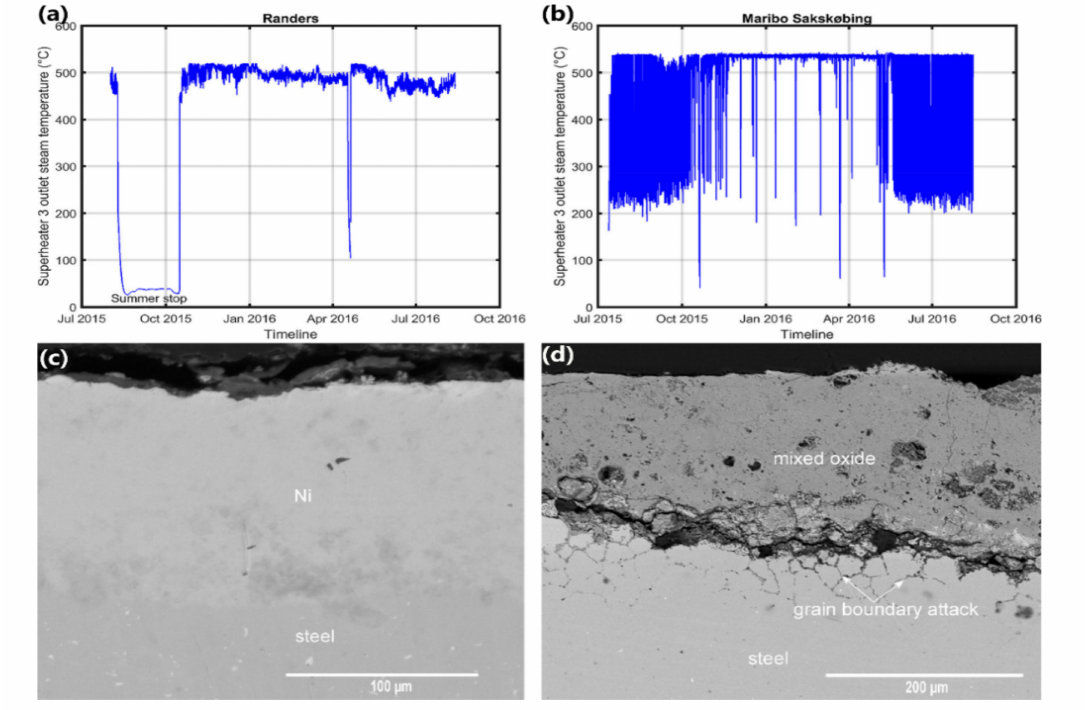
Figure 2. Outlet steam temperature date and corrosion morphology about the Ni-coated tubes in ( a , c ) Randers; ( b , d ) MSK [25].